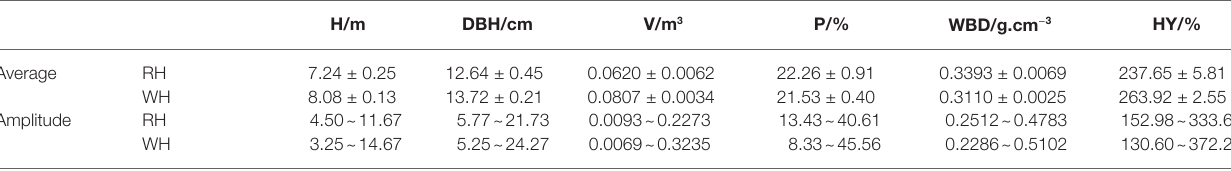
TABLE 1 | Differences in growth-related traits of red- and white-heart Chinese